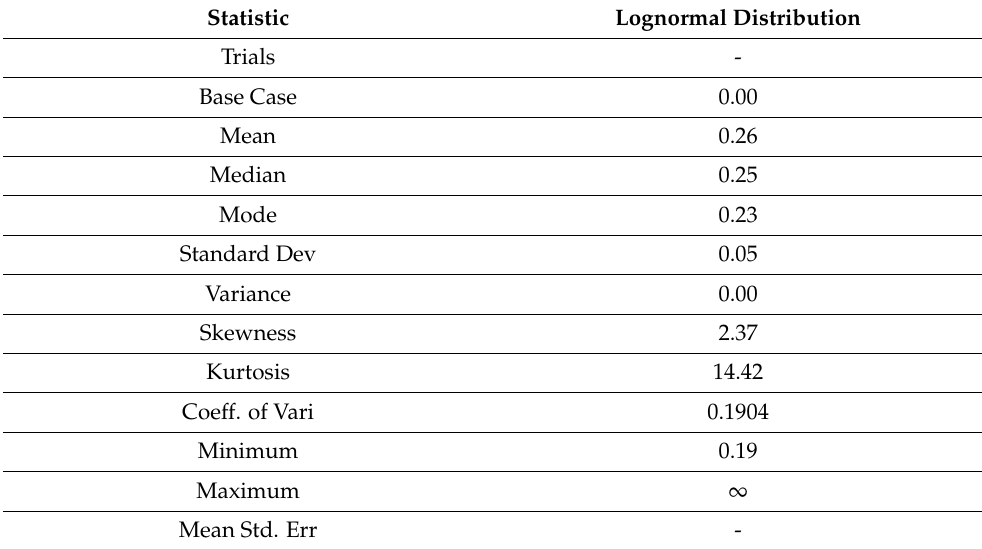
Figure 5. Probability of distribution of rental prices for a standard double-room in Bratislava.